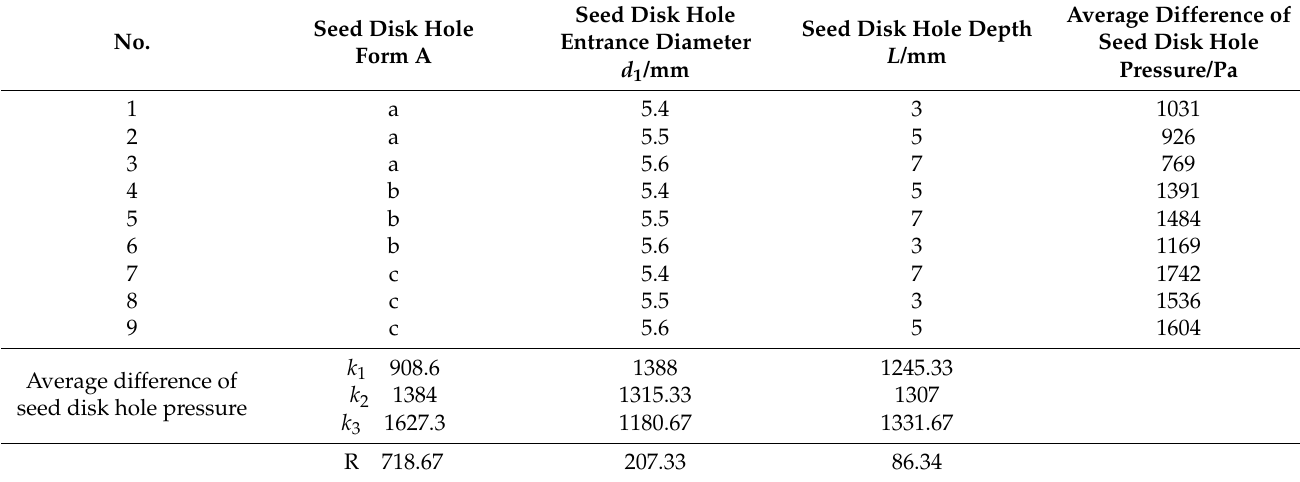
Table 4. Orthogonal experimental results.